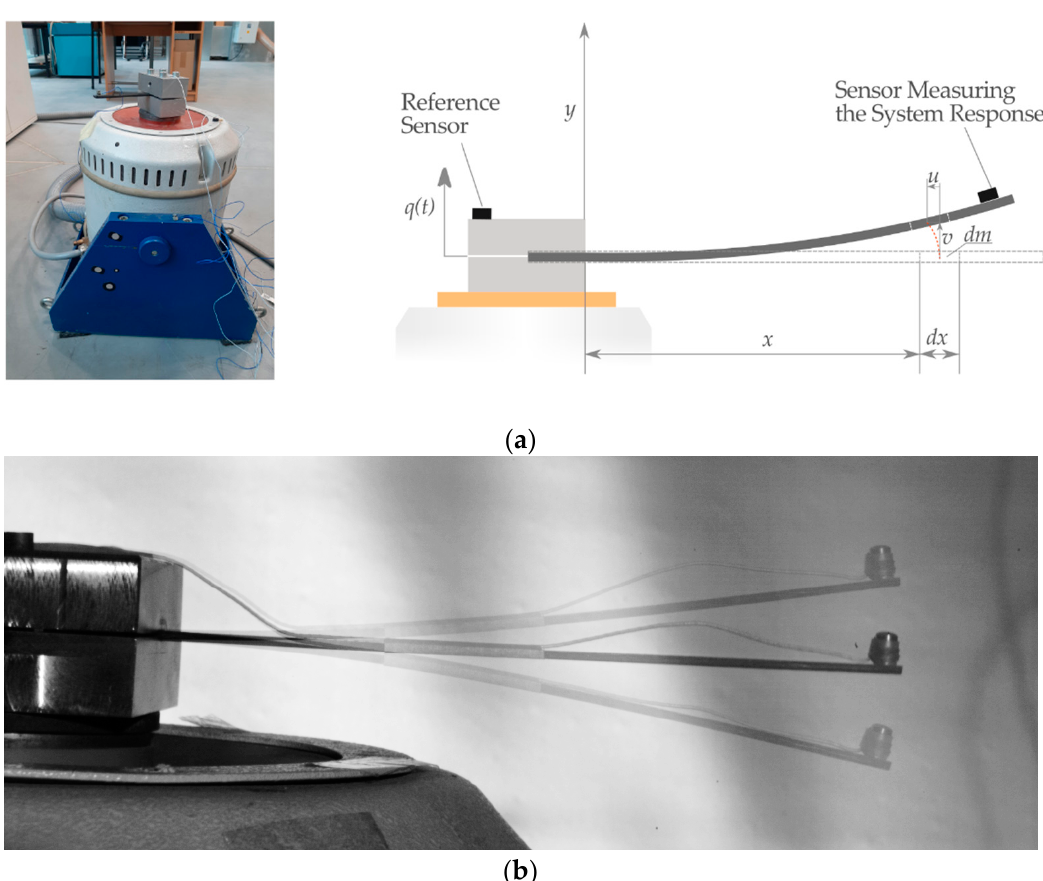
Figure 3. ( a ) The experimental setup and the scheme of the vertically excited composite beam and ( b ) the captured views of the beam vibrations in the first resonance